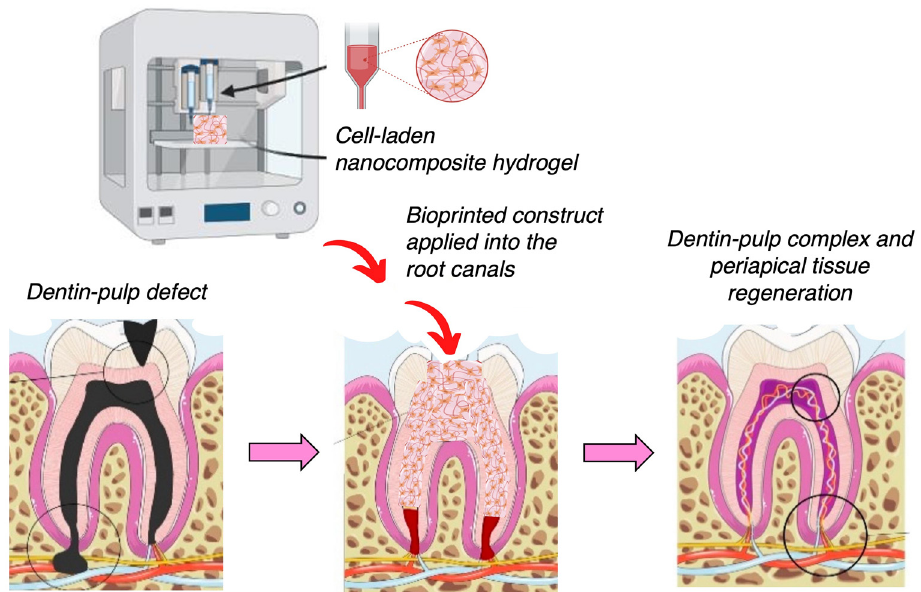
Figure 3. Bioprinting of cell-laden hydrogel constructs for the regeneration of dentin pulp (Modified image adapted with permission from [186], 2022, MDPI AG).